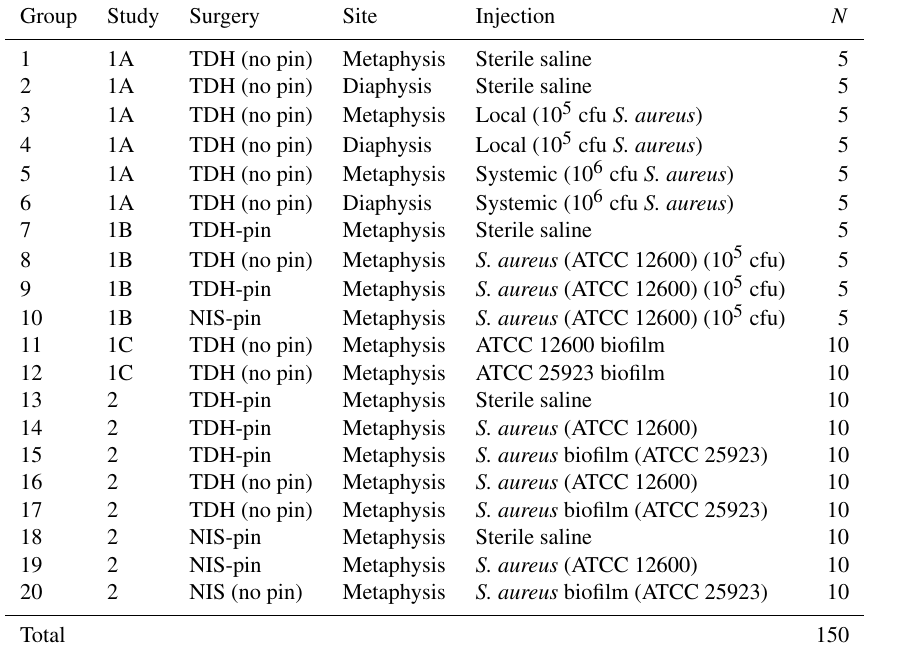
Table 1. The study plan of TDH and NIS bone infection models. Group